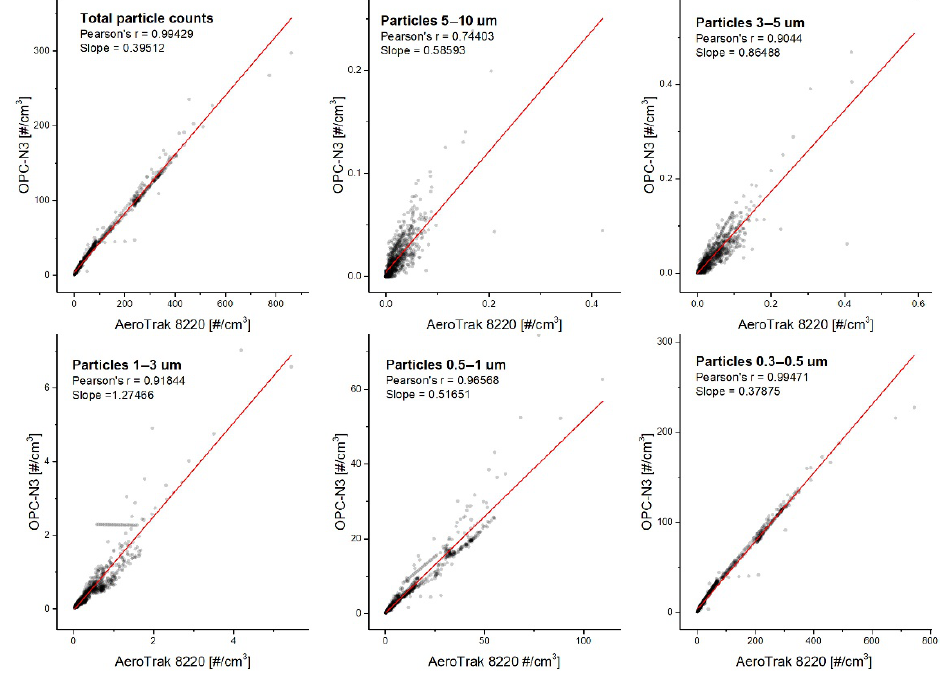
Figure 5. The correlation of particle number concentration in corresponding size bins recorded with the AeroTrak8220 and OPC-N3.